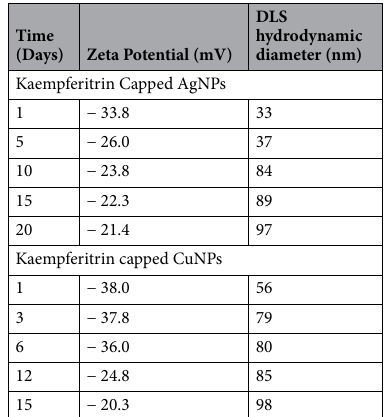
Table 2. DLS hydrodynamic diameter / Zeta Potential analysis of Kaempferitrin capped AgNPs/CuNPs.